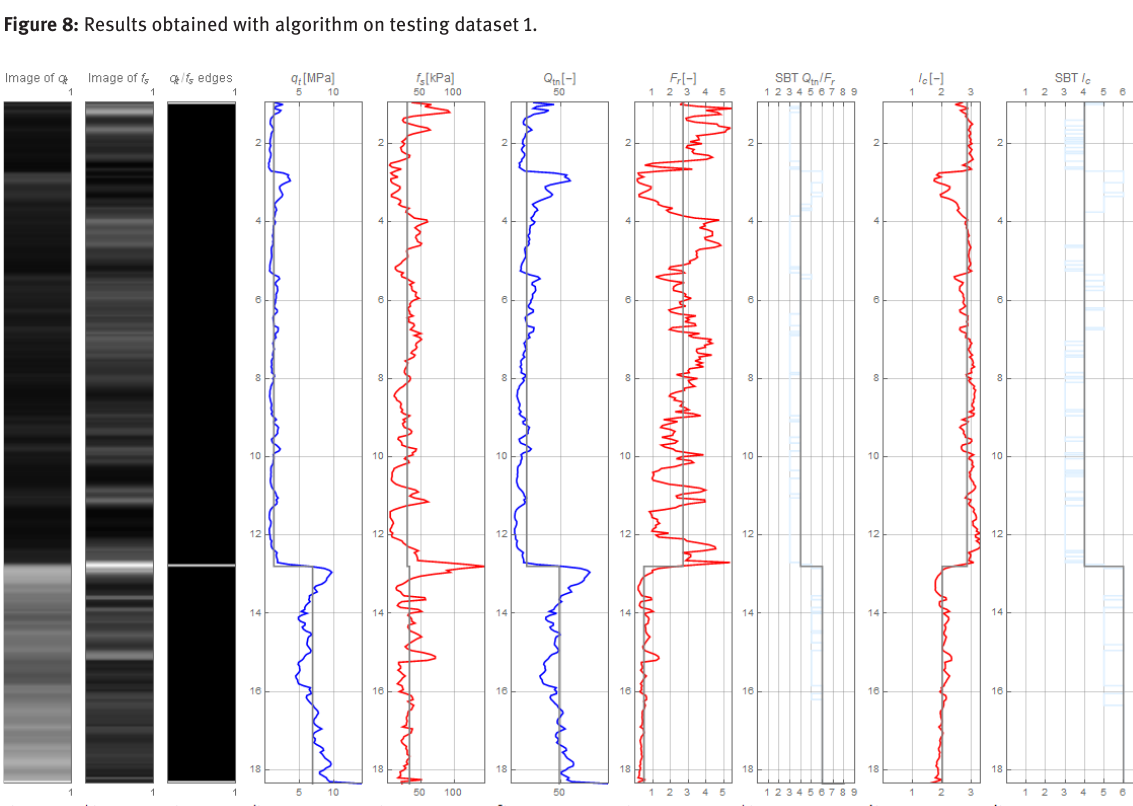
Figure 9: Results obtained with algorithm on testing dataset